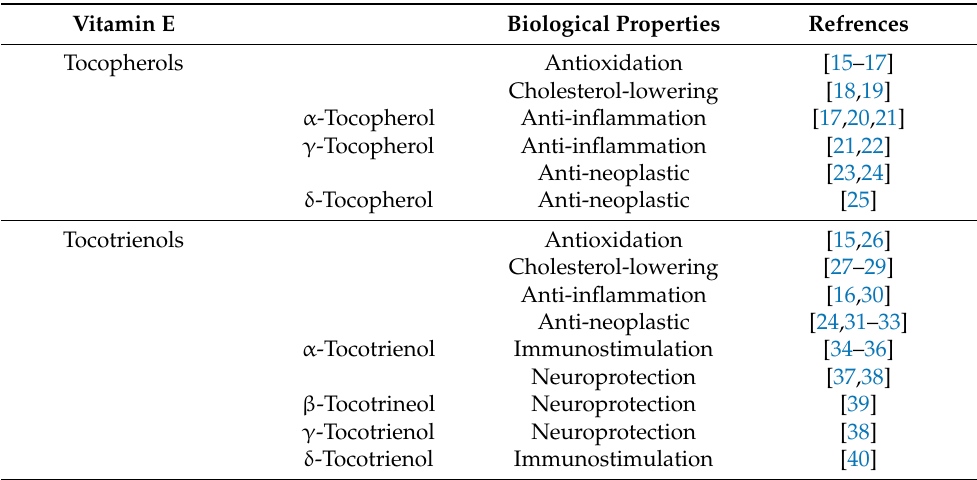
Table 1. Characteristics of vitamin E-derivates.